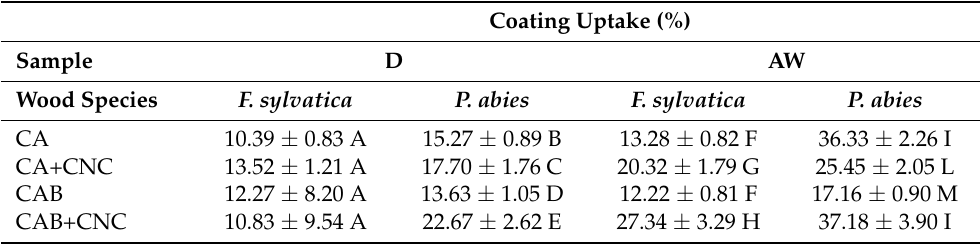
Table 3. Coating uptake (%) for the decay test (D) and for the artificial weathering (AW) samples. CA: Commercial acrylic waterborne coating. CA+CNC: CA with addition of 2% CNC gel. CAB: Commercial acrylic waterborne coating with biocides. CAB+CNC: CAB with addition of 2% CNC gel. Mean values that do not share a letter (same column) are significantly